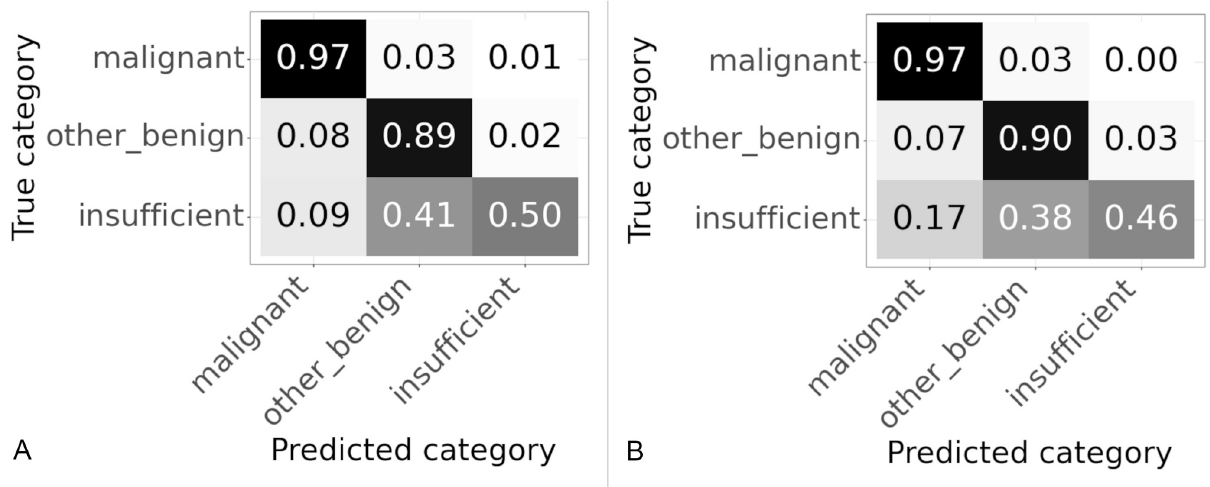
Fig 11. Confusion matrices for slide results on validation and test sets of final model. (A) Results on validation set. (B) Results on test set.